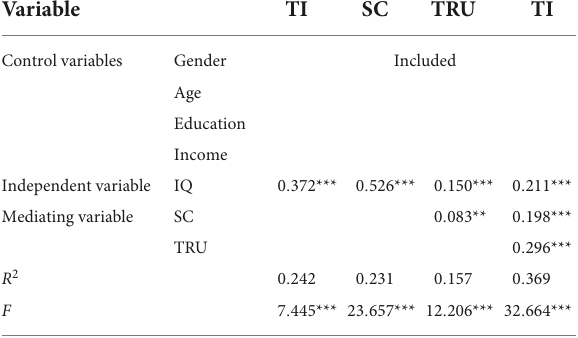
TABLE 4 Main effect and mediating